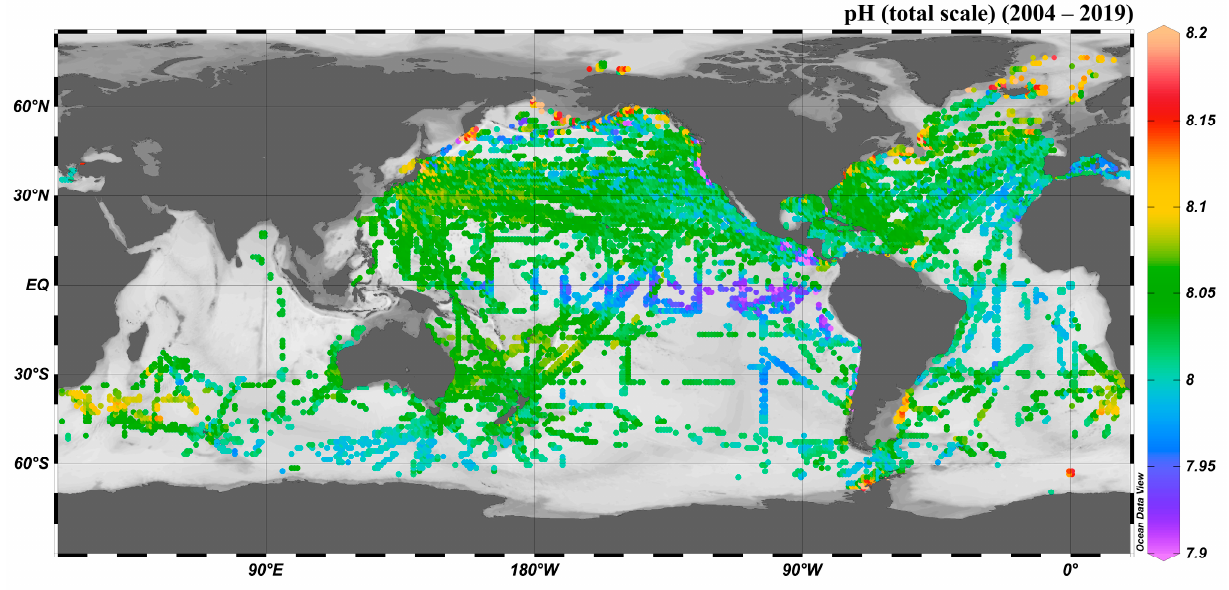
Figure 7. Spatial distribution of the pH ( in situ *) dataset matched with satellite data during the period 2004–2019 with 1,302,641 sets of data.